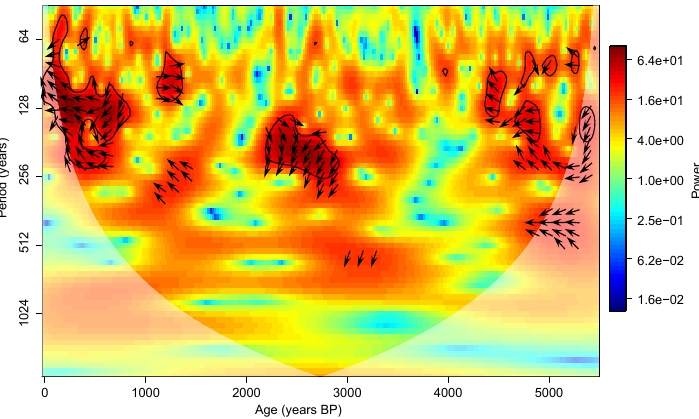
Figure 6. Cross-wavelet analysis of the Ammersee flood layer (30-year running window) and reconstructed total solar irradiance records (Steinhilber et al., 2012). Contoured areas exceed the 90% significance level against a red noise spectrum. Arrows pointing to the left indicate that the time series are anti-phased. Before the analysis, the Ammersee flood layer record was resampled to the resolution of the TSI time series (approximately one data point in 20 years). Shaded areas indicate the cone of influence where wavelet analysis is affected by edge